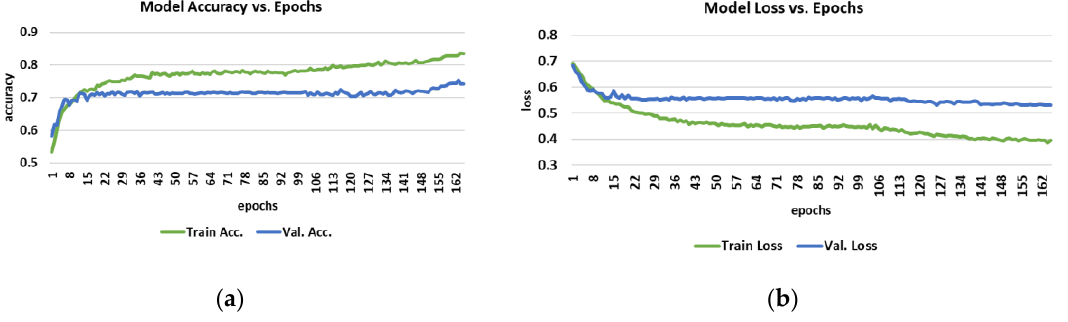
Figure 6. Model performances (%) of the proposed Dual-CNNSELSTM model with the hand gesture dataset. ( a ) Training and validation accuracy; ( b ) training and validation loss.